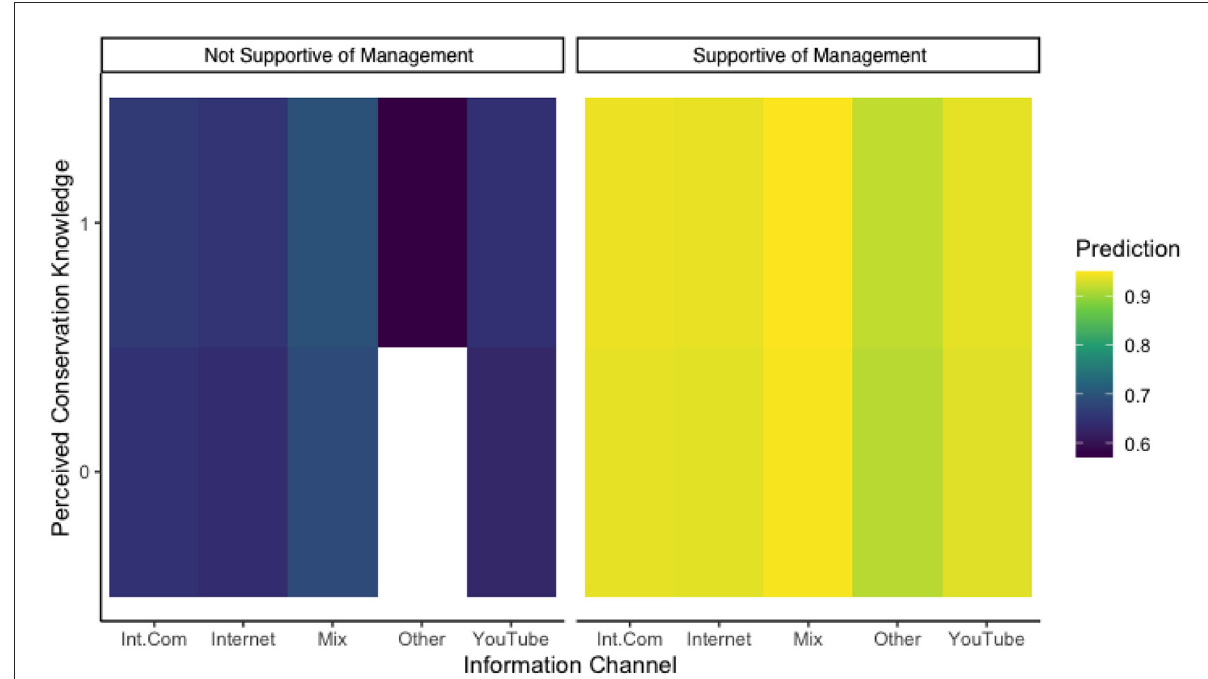
FIGURE2 Color-coded binary logistic regression model predictions (Model C) for Pro-Environmental Behavioral Intention considering all predictor variables. The graphs are divided based on Management Support. Perceived Conservation Knowledge is displayed along the y-axis (0 = Perceived themselves as not knowledgeable and 1 = Perceived themselves as knowledgeable), and the Information Channel categories are displayed along the x-axis (Mix = Combination of channels, Int.Com = Interpersonal Communication). Model prediction values closer to a value of 1 (lighter colors) = Likely to engage in pro-environmental behavior, model prediction values closer to 0 (darker colors) = Not likely to engage in pro-environmental